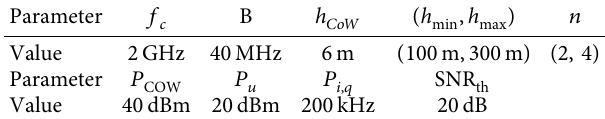
Table 1: Values of the evaluation parameters.